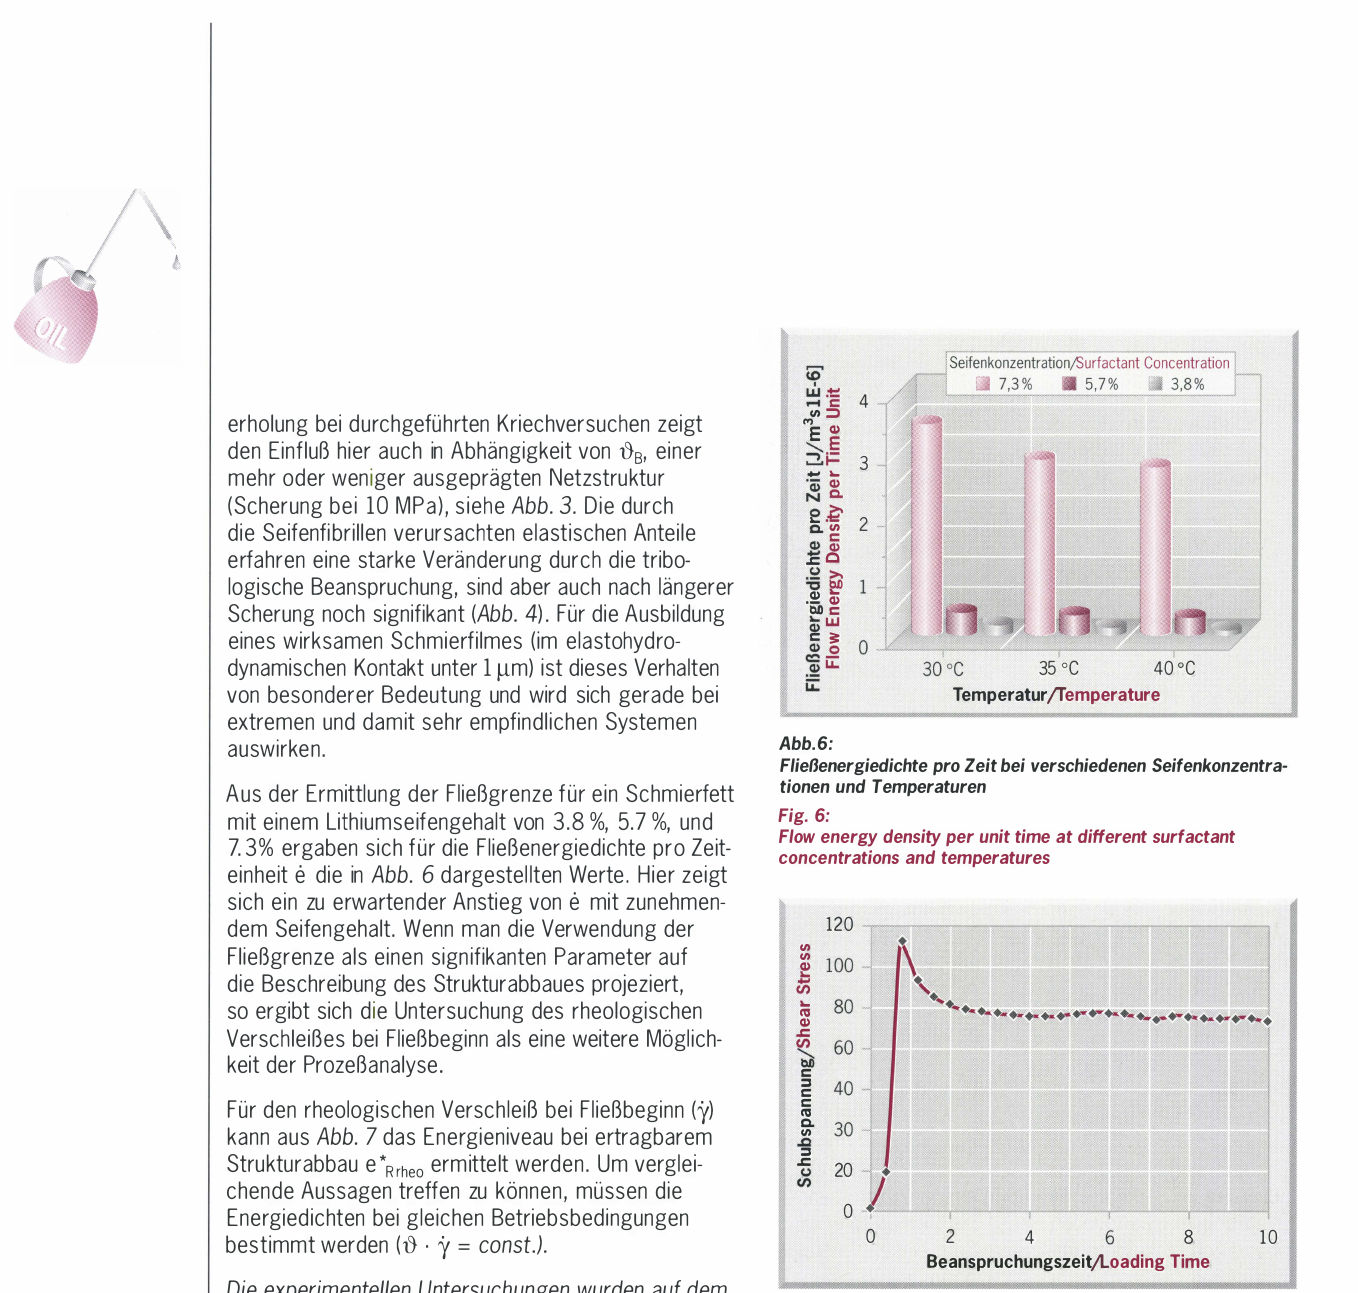
Fig.l: Rheological degradation at the onset of flow for a grease with 7.3% surfactant parameter to describe structural degradation,